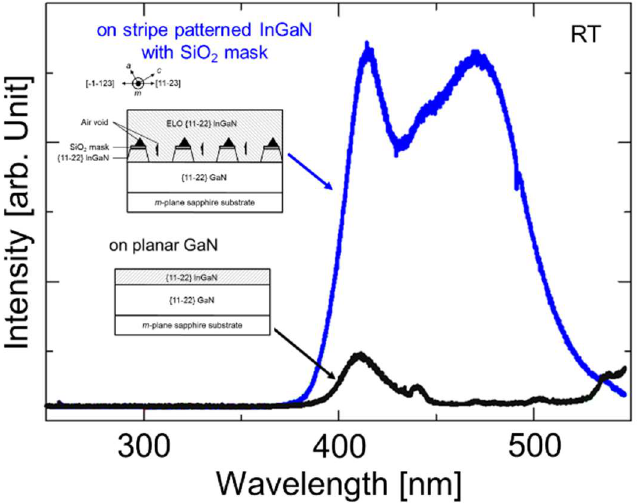
Figure 7. The PL spectra of the {11-22} InGaN layers grown on the planar GaN template and stripe-patterned InGaN template with SiO 2 masks.